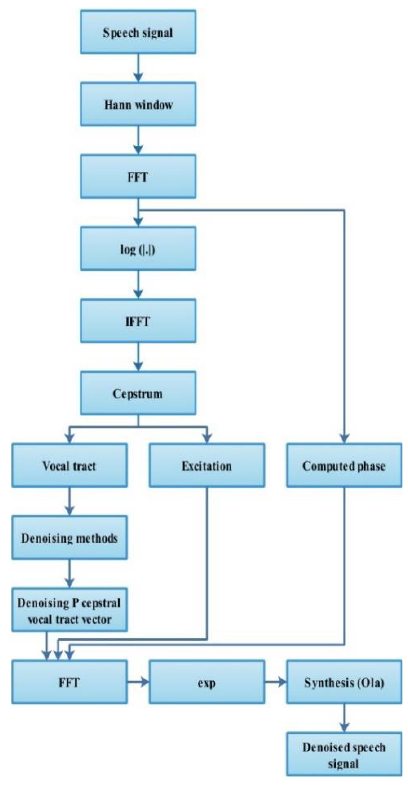
Fig. 4. Schema of hybrid method 1.